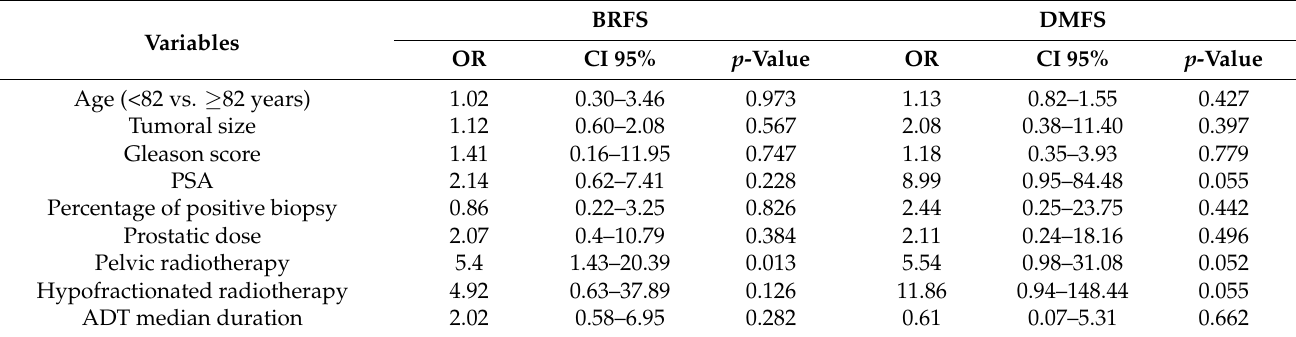
Table 3. Biochemical recurrence-free survival (BRFS) and Distant metastasis-free survival (DMFS) in high-risk ≥ 80 years patients (group B; n = 60) . Univariate